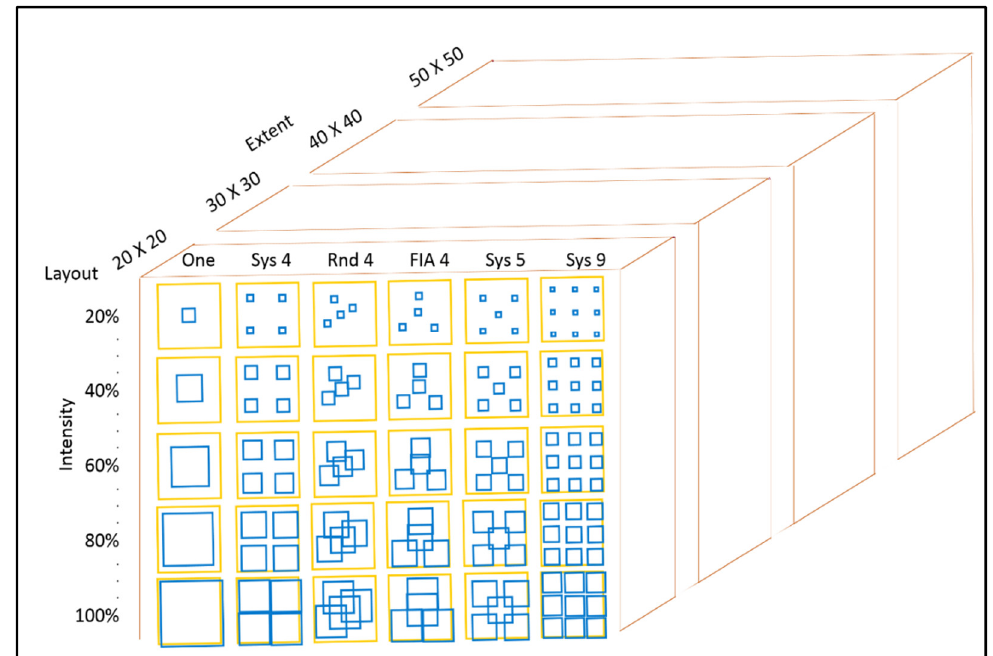
Figure 4. Subsampling layout and subsampling intensity for varying sample unit sizes. Yellow square boxes define the spatial extent sampled within an image, while the shifted blue boxes illustrate the impact of co-registration errors and define a subsampling layout and proportion of area measured within each yellow extent. Large brown cubes denote iterations for potential sample unit sizes.